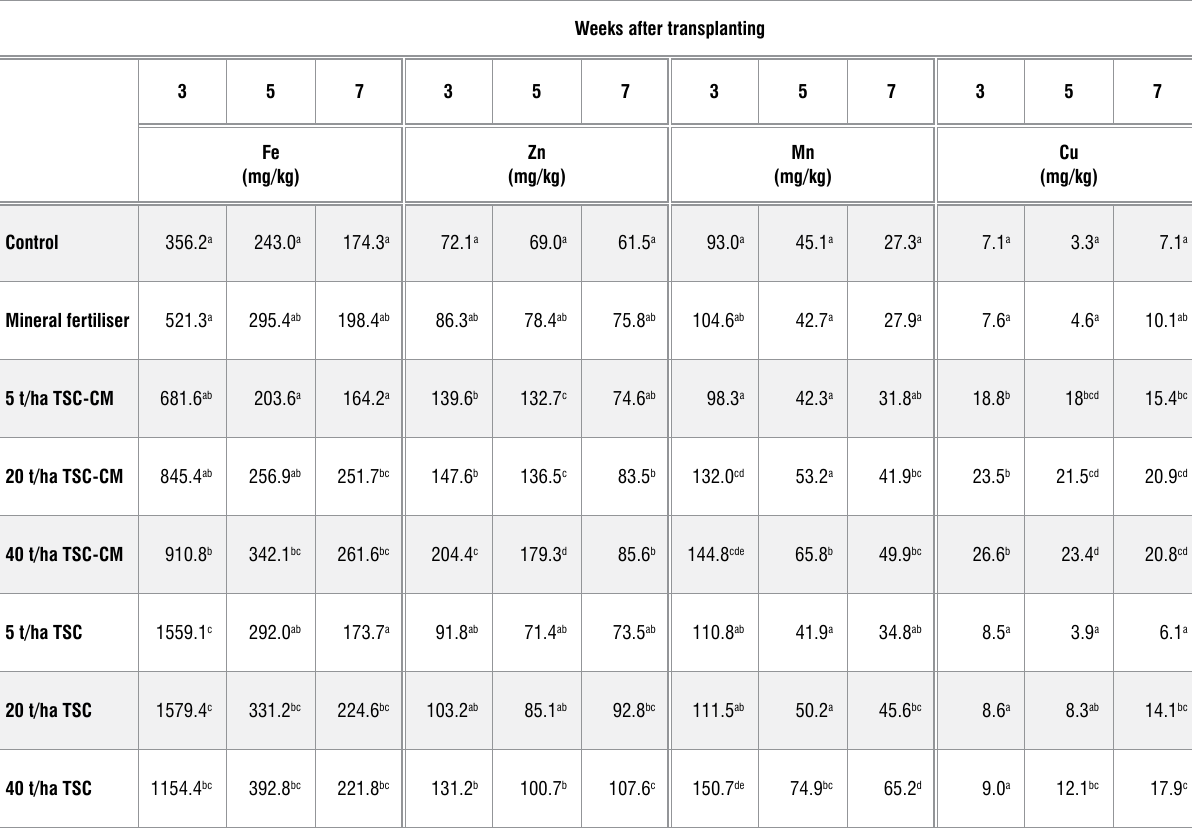
Table 2: Micronutrient concentration in oilseed rape ( Brassica napus L.) leaf tissue